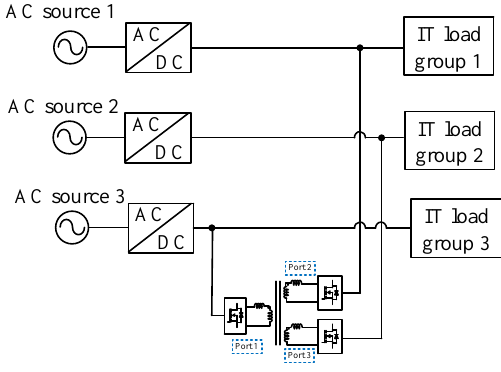
Figure 17. Improving the reliability of power distribution for data center by using TAB converter.